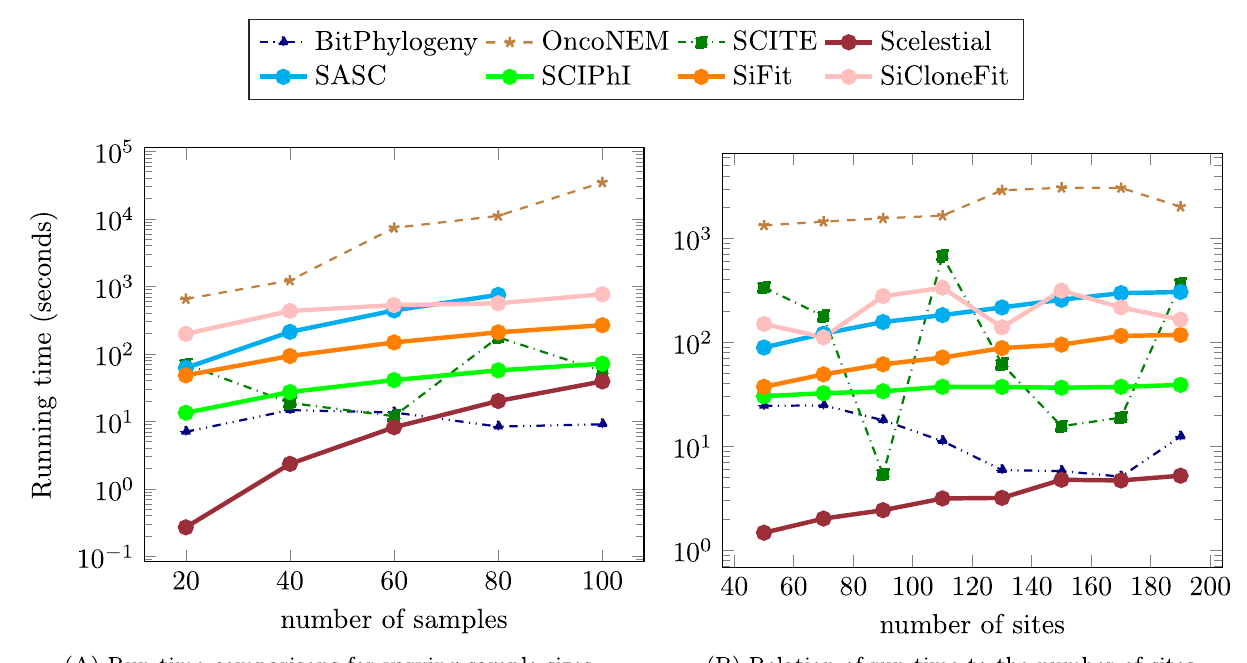
Fig 7. Run time comparison in relation to the number of samples and